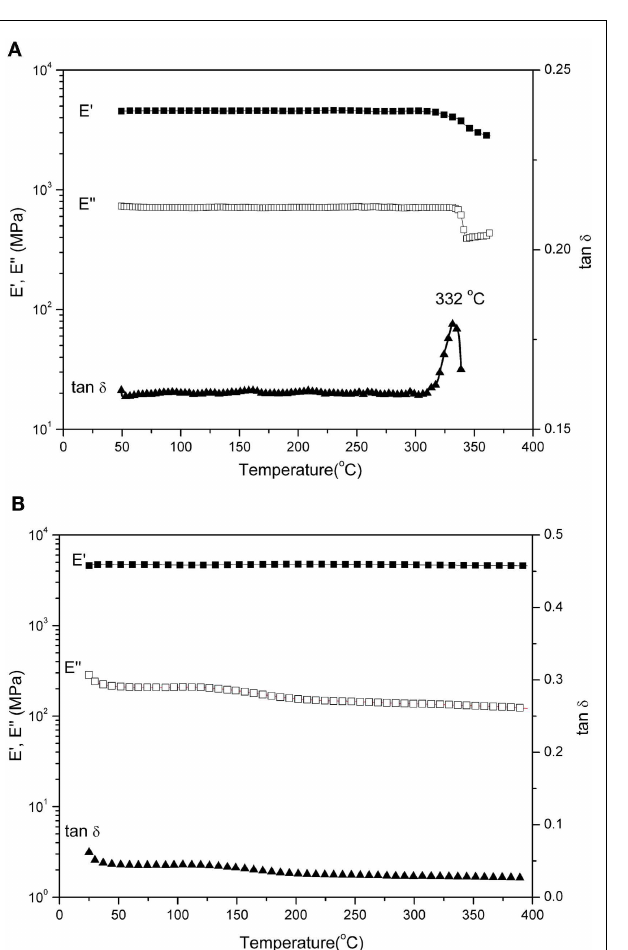
FIGURE 11 | Dynamic mechanical spectra of poly( o AI-a)-300 (A) and poly( o AI-ddm)-300 (B) .